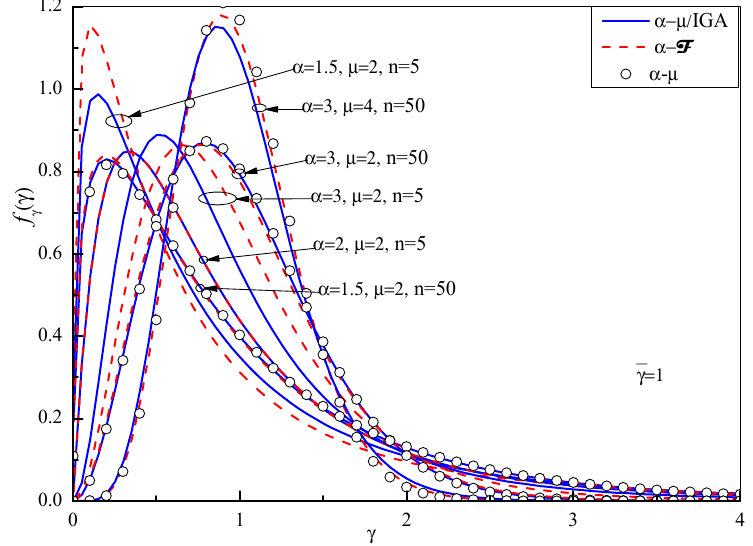
Figure 1. PDFs of the α - μ /IGA and α - ℱ models for different channel parameters with 𝛾̅ = 1 .